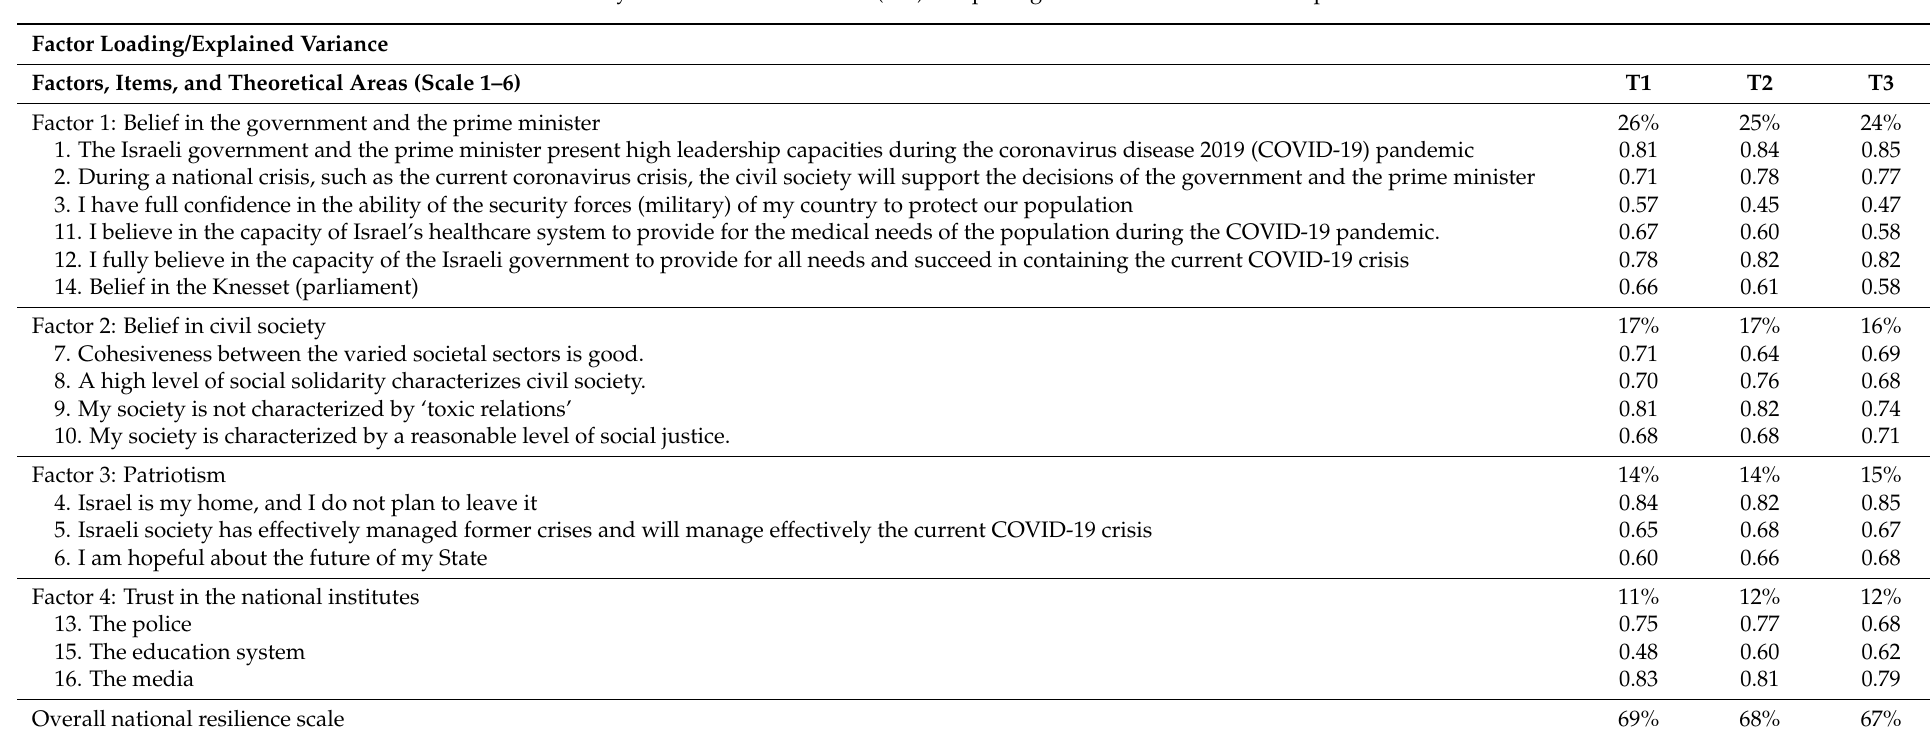
Table 2. Factor analysis on national resilience (NR) comprising 16 items across the three repeated